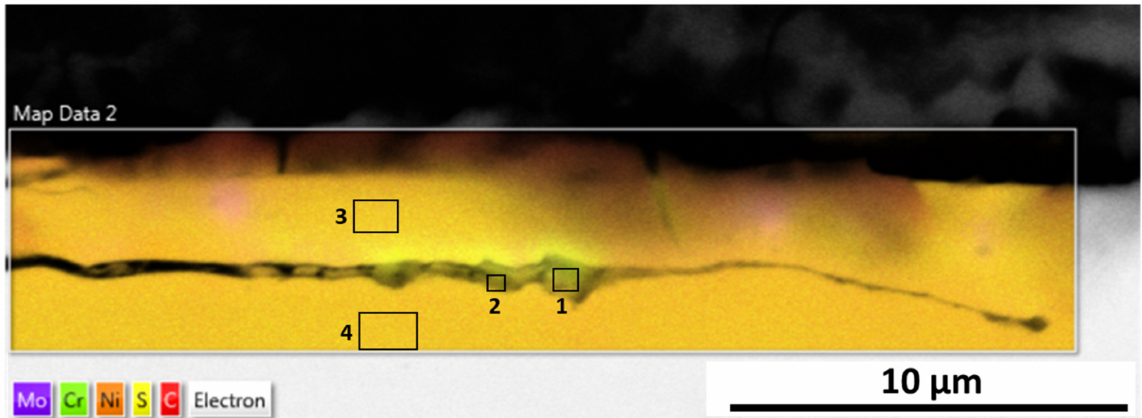
Figure 11. Elemental mapping and EDX analysis of Inconel 625 exposed in Reykjanes, which showed crack propagation that might have initiated from inclusions as a high amount of Nb is present in location 1. Nb carbides are commonly found inclusions within Inconel 625 [63]. The measured area within the crack shows traces of S in locations 1 and 2. The colour map shows the relative composition of Mo, Cr, Ni, S and C in the